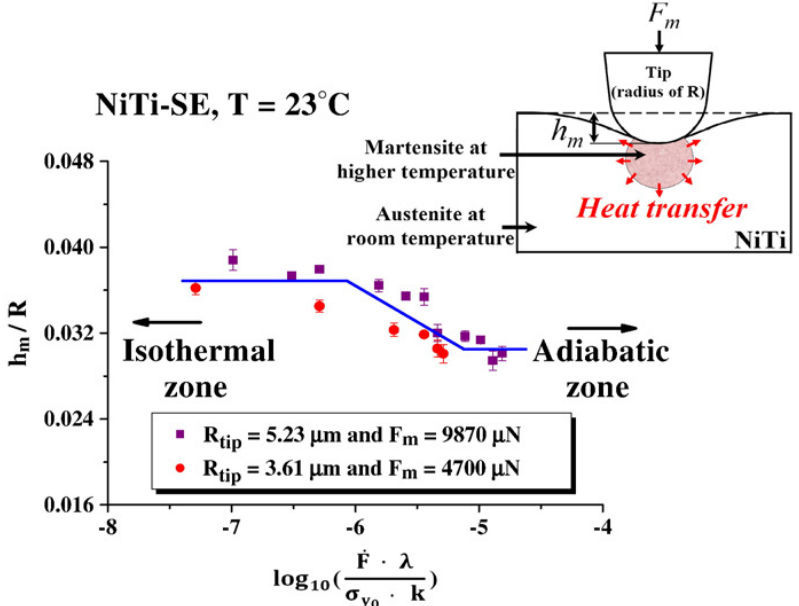
Figure 7. The rate dependence of the normalized indentation depth on the normalized loading rate parameter. A sketch of the heat transfer during indentation is drawn at the top right corner [35]. (Reprinted from Ref. [35], Fig. 3, 2011, with permission from Elsevier.)